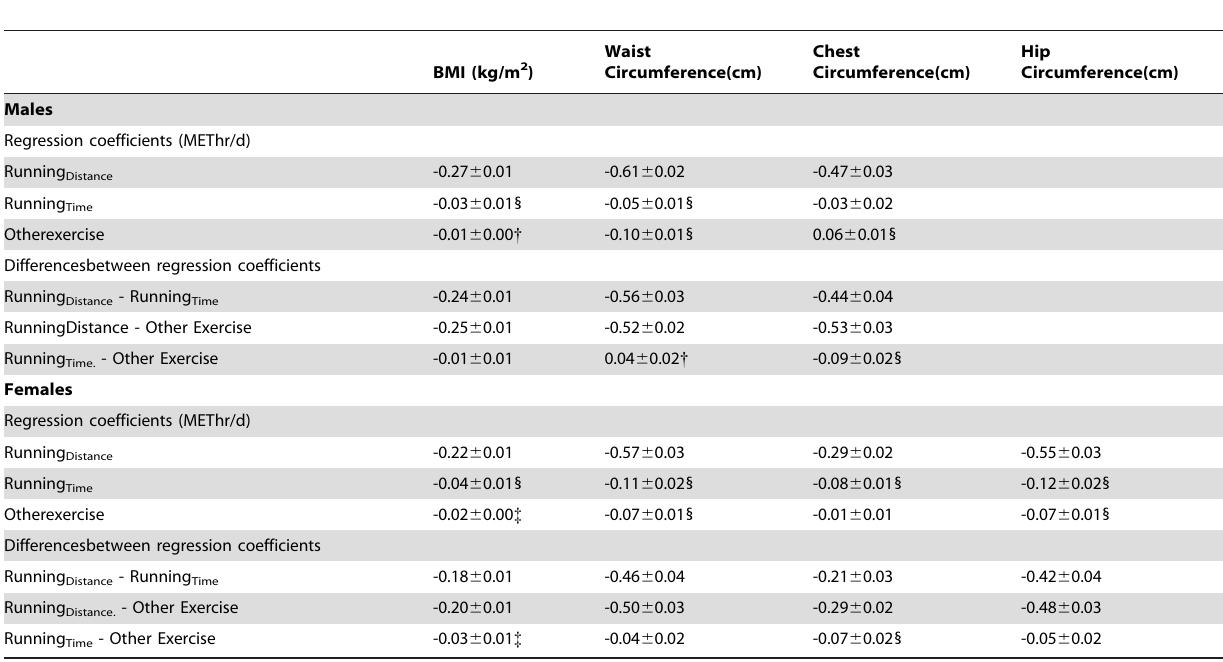
Table 4. Cross-sectional regression slopes ( 6 SE) of BMI and body circumference measurements (dependent variables) versus METhours per day of running and other physical activities (independent